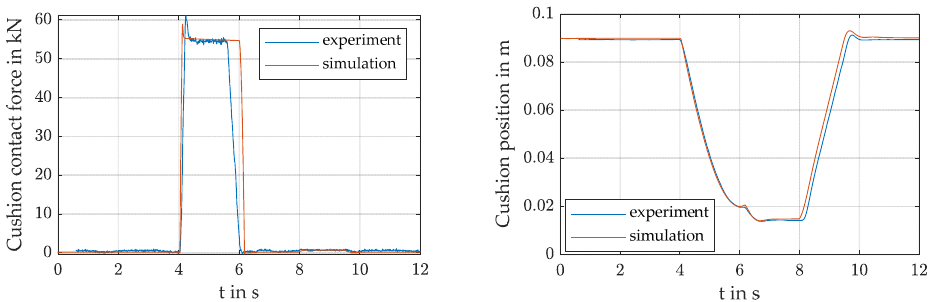
Figure 4. Cushion contact force and position at 1600 rpm and contact force of 55 kN from experiment and simulation.